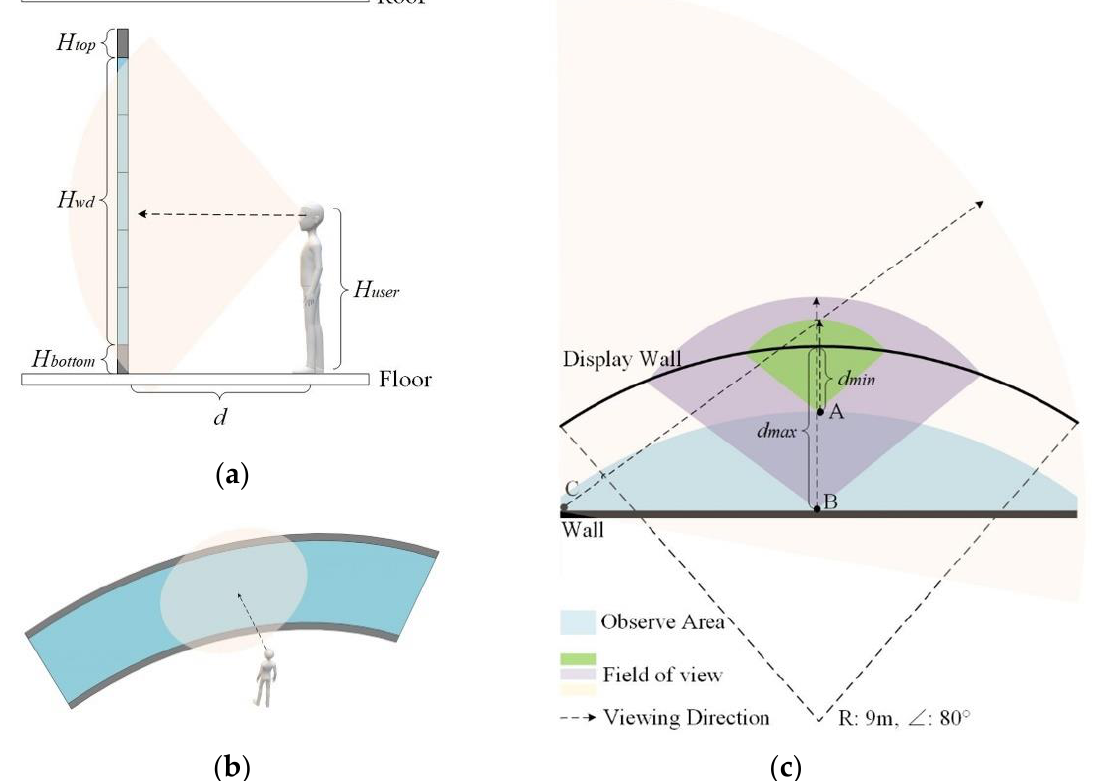
Figure 2. Observation area analysis. ( a ) is a side view of the display wall system; ( b ) indicates that the user's attention is focused on the inside of the display area; ( c ) is the top view of the display wall system.